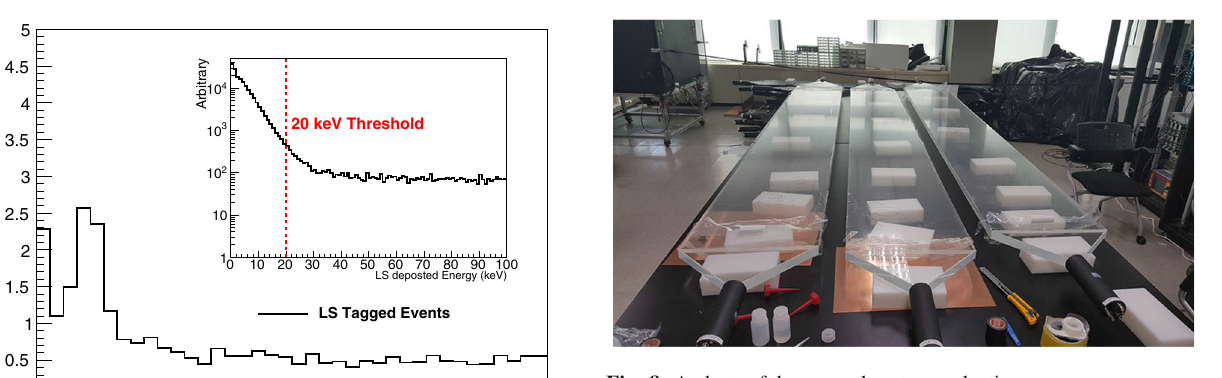
Fig. 8 A photo of the muon detector